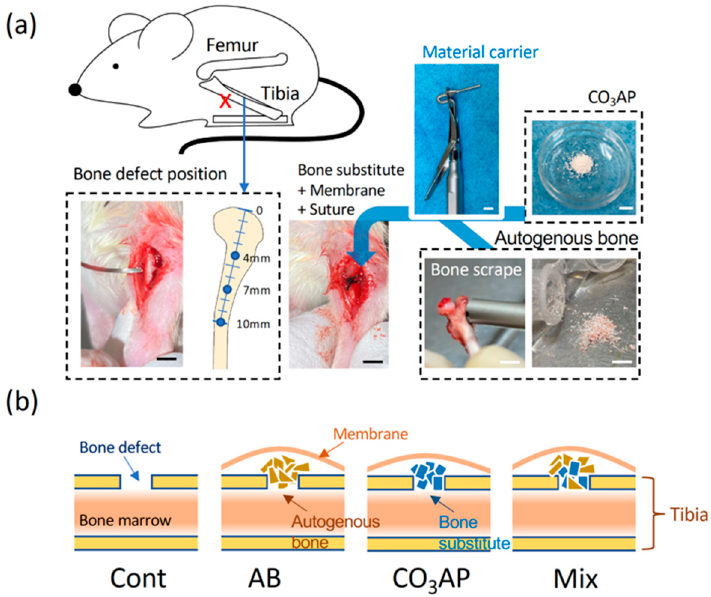
Figure 2. ( a ) Tibia defect and preparation of autogenous bone. A hole was created in the tibia (red X) using a round bur, material was inserted using a filling tool (material carrier), and the hole was covered with a membrane and two sutures. Scale bar = 5 mm. ( b ) Experimental group. For the control, nothing was inserted into the tibia hole. In the autologous group, a separate dry tibia was used. In the Mix group, a 1:1 volume of scraped bone and CO 3 AP was used to fill the hole.